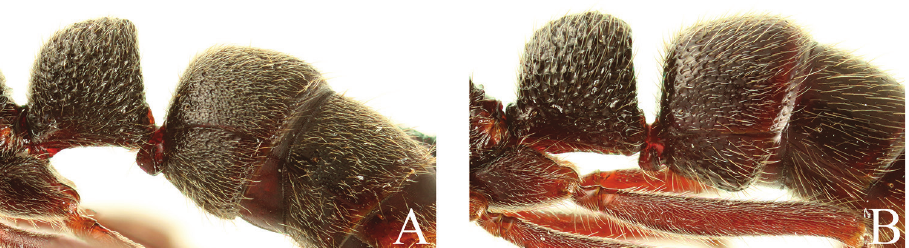
Figure 19. Petiole and gastar, lateral view. A L. curva B L. kanaoi .